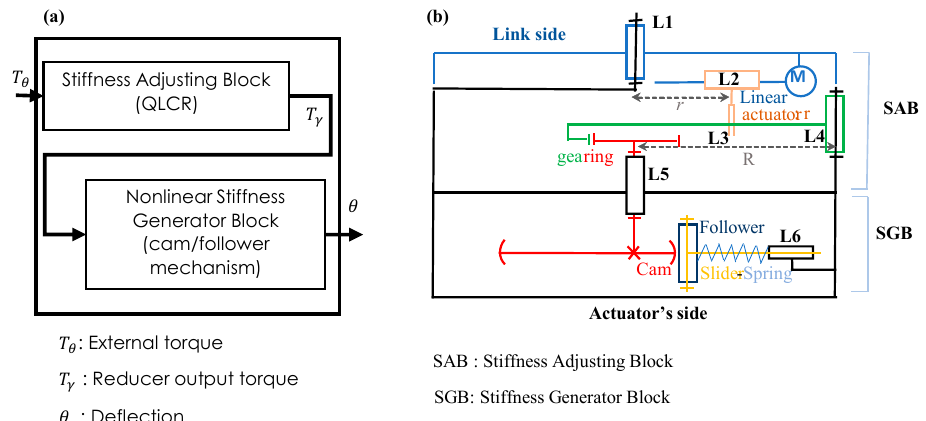
Figure 3. Block representation of the V2SOM, ( a ) Two functional blocks of V2SOM ( b ) V2SOM kinematic scheme.